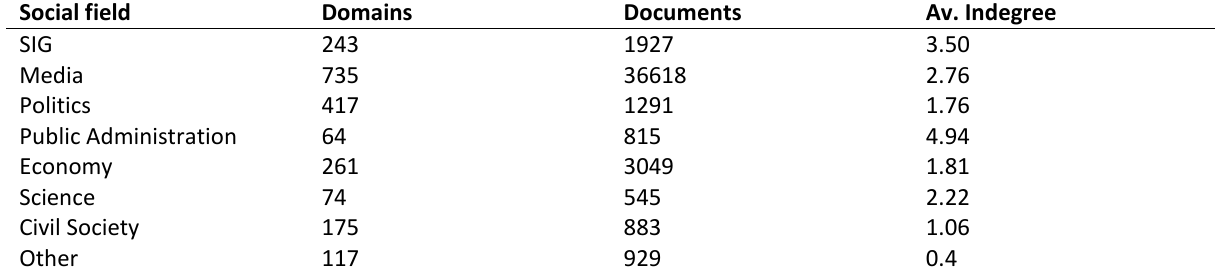
Table 3. Social fields’